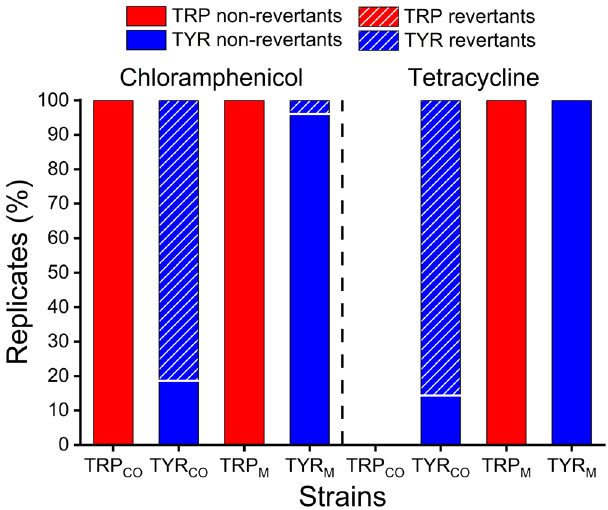
Fig. 5 Environmental stress favours reversion to metabolic autonomy. Shown is the population-level proportion of initially auxotrophic genotypes that evolved in the presence of chloramphenicol (left) and tetracycline (right), which remained auxotrophic ( fi lled bar) or reverted to prototrophy (hatched bars). Tryptophan auxotrophic strains (TRP) are depicted in red and tyrosine auxotrophic strains (TYR) in blue. Populations of monoevolved genotypes (TRP M , TYR M ) and genotypes isolated from coevolved cultures (TRP CO , TYR CO ) are compared. The plotted colony counts (%) are the number of colonies analysed per strain relative to the total number of colonies tested in the respective cultures. In both treatments, the reversion rates of coevolved tyrosine auxotrophs were signi fi cantly higher than those of their monoevolved counterpart (chloramphenicol-treated TYR two-sided Pearson χ 2 test: P = 5.4 × 10 − 70 , n = 240 – 285; tetracycline-treated TYR two-sided Pearson χ 2 test: P = 4.8 × 10 − 92 , n = 240 – 342). Source data are provided as a Source Data fi